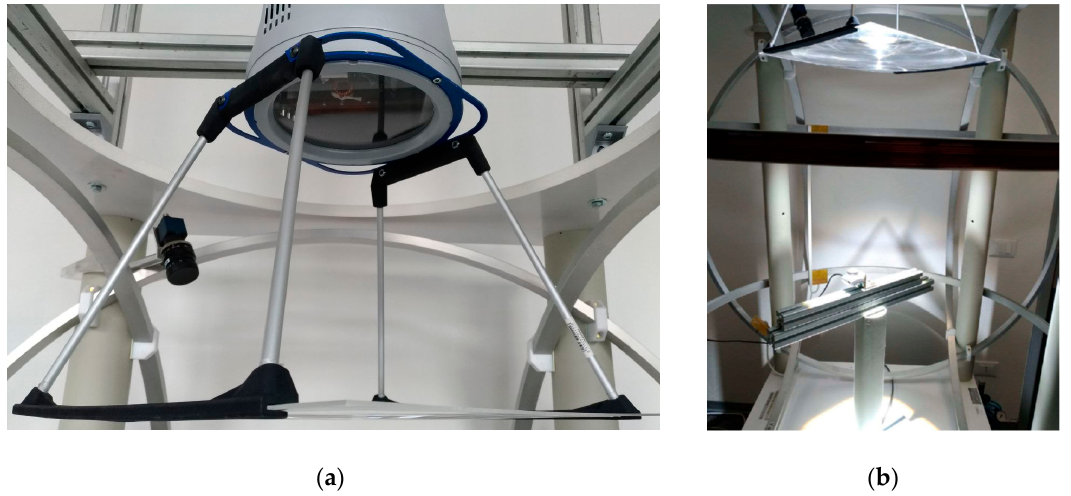
Figure 9. Sun Simulator. ( a ) Detailed view of Sun simulator with collimation device; ( b ) test setup for temporal stability and spatial uniformity measurements using a pinhole camera.